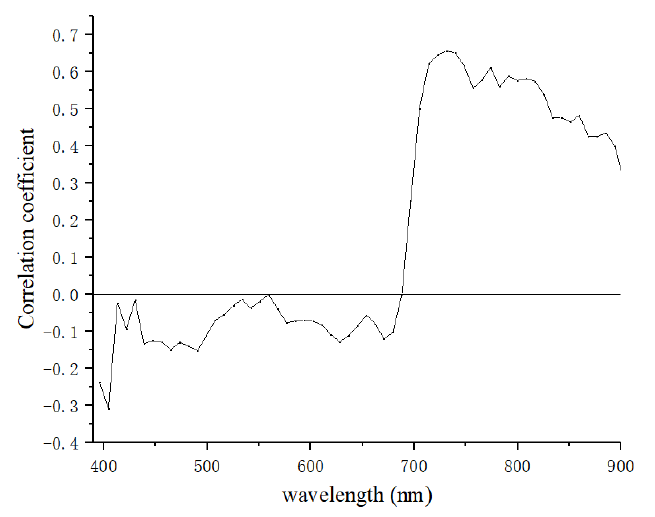
Figure 6. Plot of the correlation coefficient versus